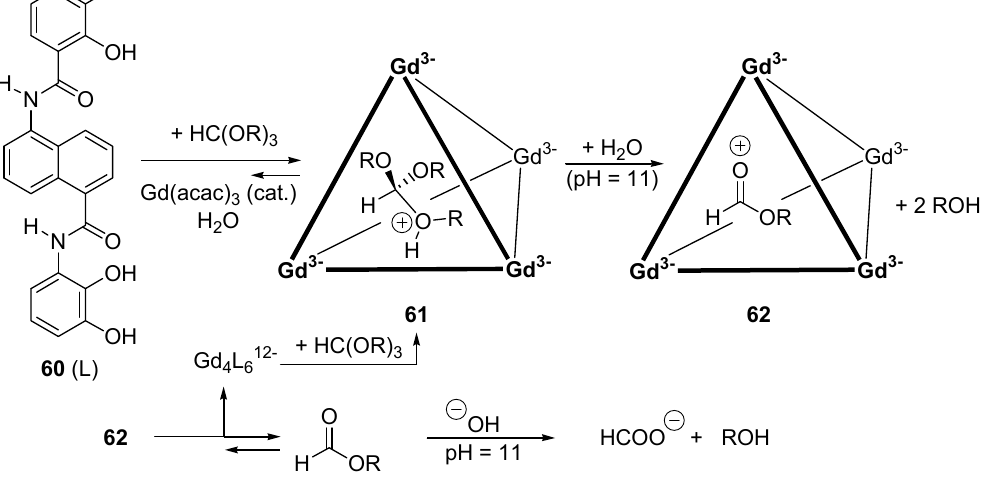
Figure 10. Catalysis by supramolecular assembly. Hydrolysis of orthoesters under alkaline conditions.